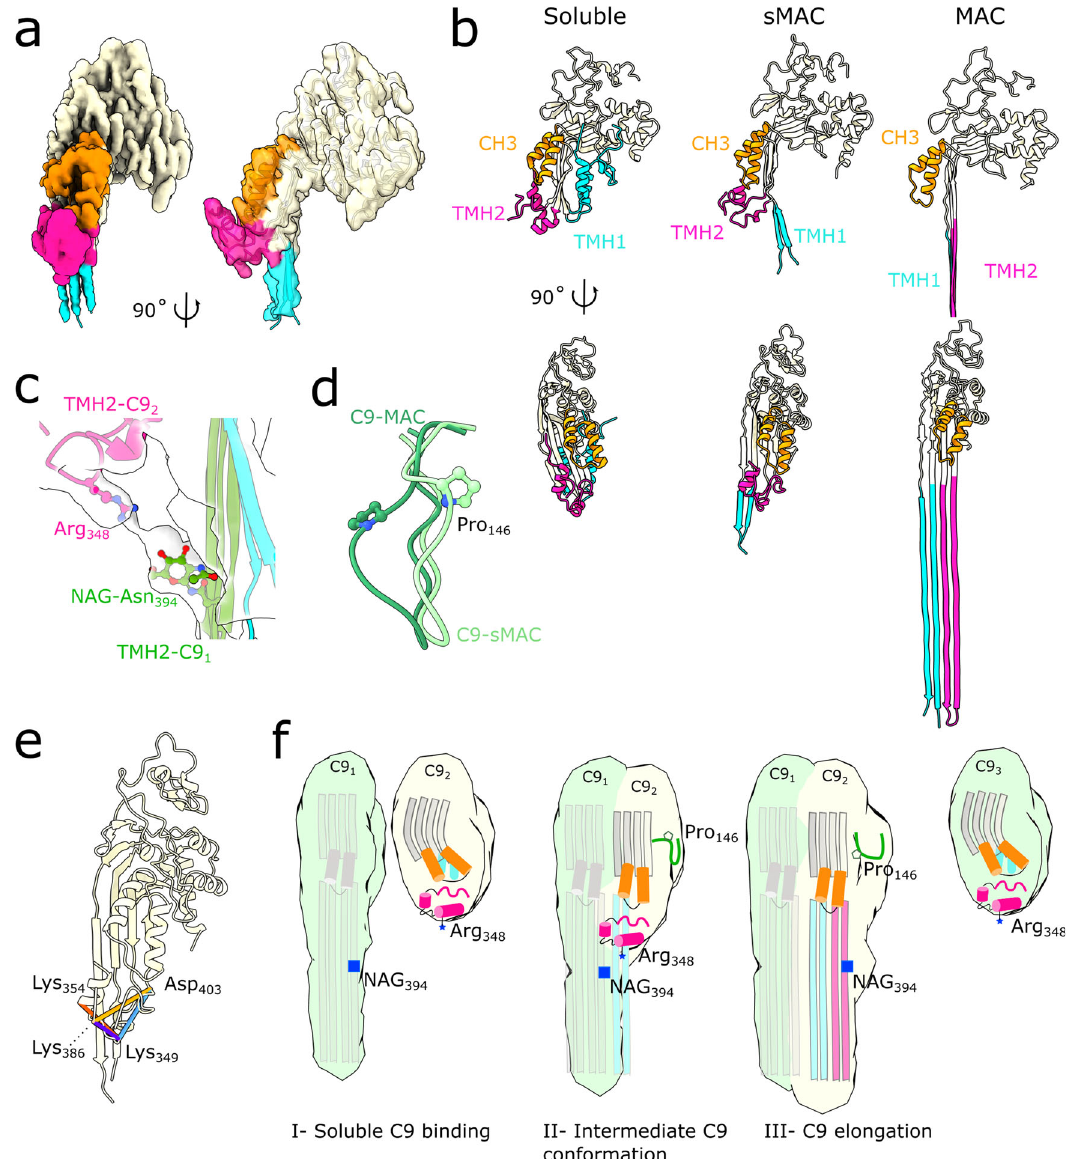
Fig. 4 sMAC traps an alternative conformation of C9. a Density for the terminal C9 in the 2C9-sMAC reconstruction (EMD-12647). Density corresponding to the CH3 (orange), TMH2 (pink) and TMH1 (cyan) regions of the MACPF domain are highlighted. The remainder of C9 is beige. Model for the alternative C9 conformation is overlaid (ribbon). b Ribbon diagrams for three conformations of C9: soluble C9 from the murine crystal structure (PDB ID: 6CXO) left panel, terminal C9 in 2C9-sMAC, and transmembrane conformation of C9 in MAC (PDB ID: 6H03). CH3, TMH1, and TMH2 regions of the MACPF domain are colored as in a. For the MAC conformation, the full length of C9 TMH hairpins are shown in the bottom right panel. c Interaction between the penultimate C9 TMH2 β -hairpins (green) with the helical TMH2 of the terminal C9 (pink). Side-chains of interface residues (NAG-Asn 394 and Arg 348 ) are shown as sticks. TMH1 of the terminal C9 (cyan) is shown for context. Density for this region is shown as a transparent surface. d Superposition of the C9 MACPF from MAC (dark green) and the conformation in the terminal C9 (light green) shows differences in a loop that contains the disease affected residue Pro 146 (P146S). e Cross-links between TMH2 residues (Lys 354 , Lys 386 , Lys 349 , Asp 403 ) derived from XL-MS and mapped on the terminal C9 conformation of 2C9-sMAC (beige ribbons). Distance lengths: 9 Å (purple), 14 Å (red), 17 Å (blue), 20 Å (yellow) are shown. Source data are provided as a Source Data fi le. f Schematic showing structural timeline of MACPF pore formation. In the soluble conformation (C9 2 , C9 3 ), the MACPF domain comprises a central kinked β -sheet (grey) and the pore-forming residues within TMH1 (cyan) and TMH2 (pink) are helical. Upon binding the leading edge of the oligomer (C9 1 ), the central β -sheet straightens and two other MACPF regions: CH3 (orange cylinders) and a proline loop (dark green) rotate as TMH1 (cyan) is released. The intermediate conformation is stabilized by the interaction between a basic residue on TMH2 (Arg 348 , blue star) with a glycan on the β -strands of the preceding monomer (NAG-Asn 394 , blue square). This interaction may play a role in positioning TMH2 before the hairpins are sequentially released to propagate the